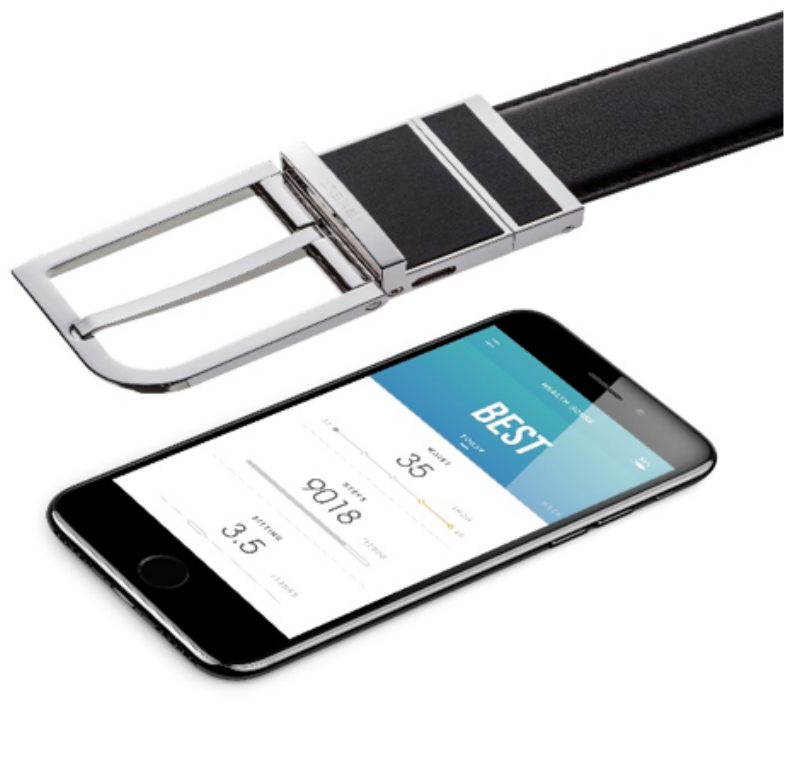
Figure 1. The WELT smart belt and mobile phone